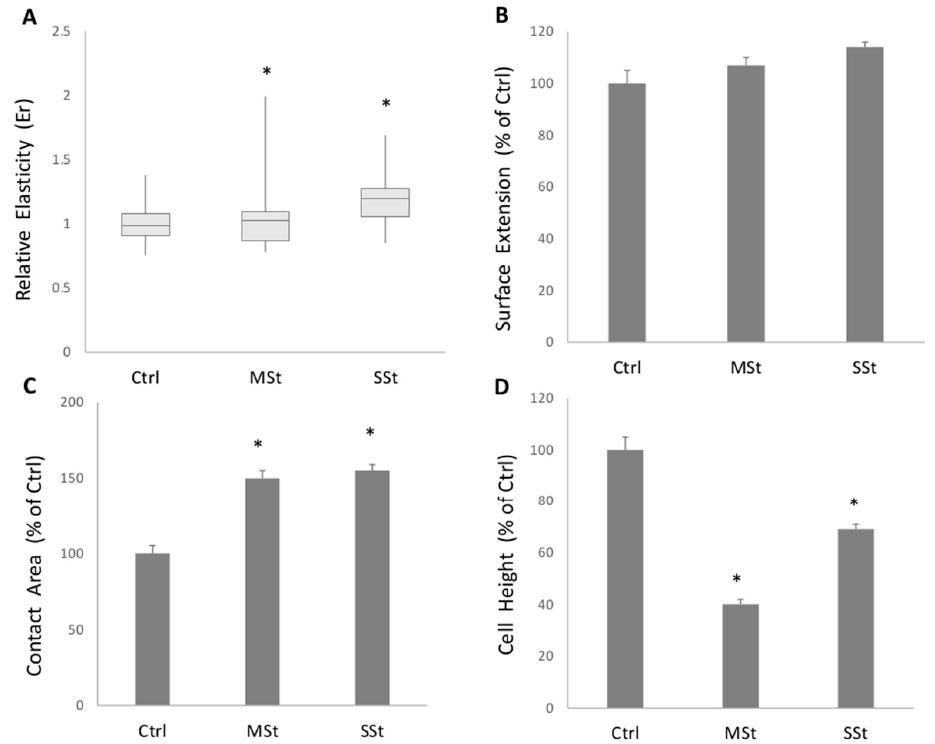
Figure 4. Changes in single cell biomechanical properties in moderate and severe steatosis mod- els. ( A ) Relative Elasticity (Er) of single cell respect to the control, obtained through the FIEL method. Symbols: Ctrl vs. all treatments * p ≤ 0.05. The morphometric indicators computed for all the treatments are presented relative to the controls: ( B ) surface extension (SE); ( C ) cell contact area (AC); ( D ) height of the cells (HC). Statistical significance respect to the control is marked when at least * p ≤ 0.05.